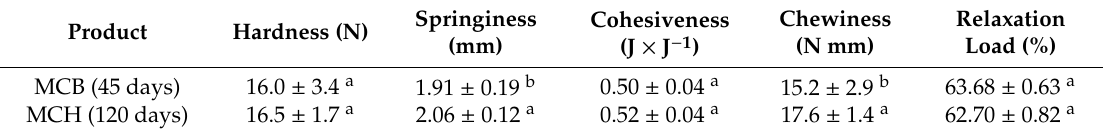
Table 4. Results of texture profile analysis and compression–relaxation test of ripened “ Mortadella di Campotosto ”-like sausages produced with beef (MCB) and hog (MCH)